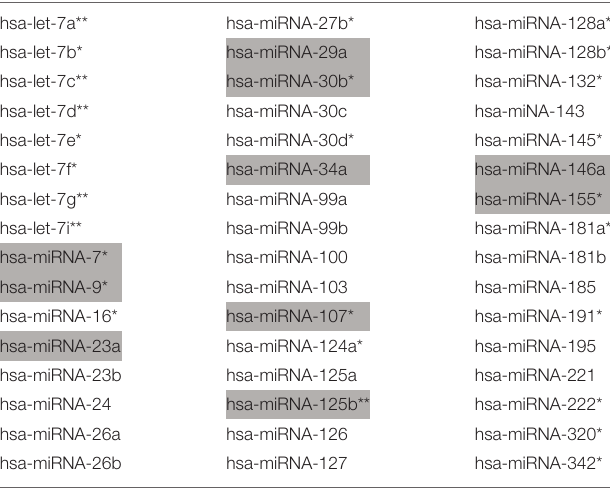
TABLE 1 | Abundant miRNA species in the human brain hippocampus from a pool of 18 control